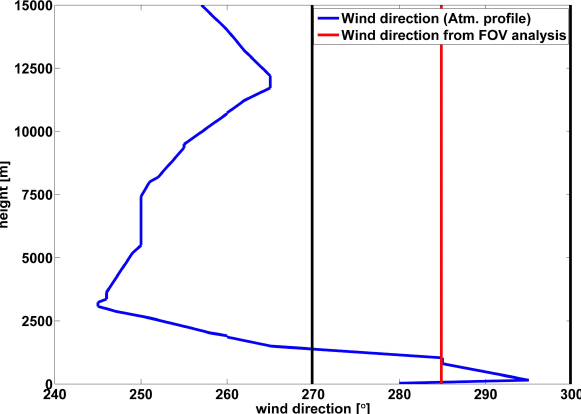
Fig. 6. Comparing measured wind direction profile (blue line) with the wind direction extracted from our FOV analysis (red line with black error values of ± 15 ◦ ). Notice that for the lower intersec- tion point of the wind speed profile in Fig. 5, the wind direction is within the error limit of the ground measurement, but for the higher intersection point the wind direction deviates from our calculated value, therefore the only valid cloud base height is the lower point at